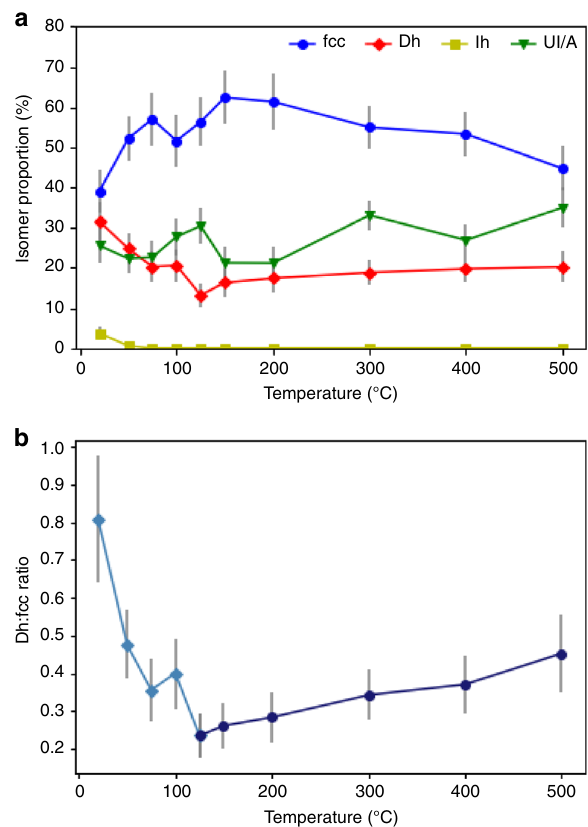
Fig. 2 The proportion of structural isomers versus temperature. a The proportion of structural isomers for Au 561 clusters on amorphous silicon nitride at ten temperatures: 20 °C, 50 °C, 75 °C, 100 °C, 125 °C, 150 °C, 200 °C, 300 °C, 400 °C and 500 °C. The clusters are classi fi ed as face- centred-cubic (circles), decahedral (diamonds), icosahedral (squares) or unidenti fi ed/amorphous (triangles). The numbers of experimental images recorded at each temperature are 133, 161, 128, 126, 151, 141, 132, 191, 167 and 143 respectively. Poisson error bars, derived from these statistics, are shown for the isomer proportions. b The ratio of Dh to fcc clusters versus temperature. The low-temperature regime (20 – 125 °C) is in diamond markers and the high-temperature regime (125 – 500 °C) in circle markers. Lines between points plotted are simply a guide to the eye. Error bars, derived according to the error propagation law, are shown for the